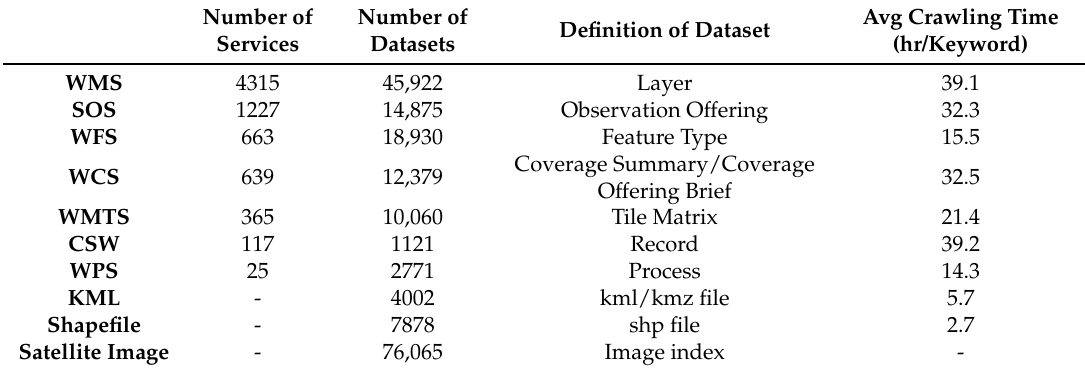
Table 3. GeoWeb crawling result.